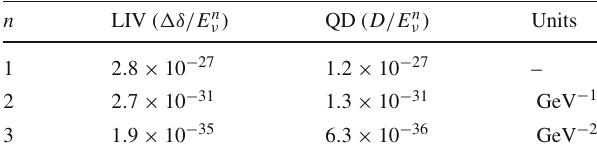
Table 2 (From Ref. [113]) 90% CL upper limits on Lorentz-invariance violation (LIV) and quantum decoherence (QD) effects. LIV upper lim- its are for the case of maximal mixing (sin 2 ξ = 1), and quantum